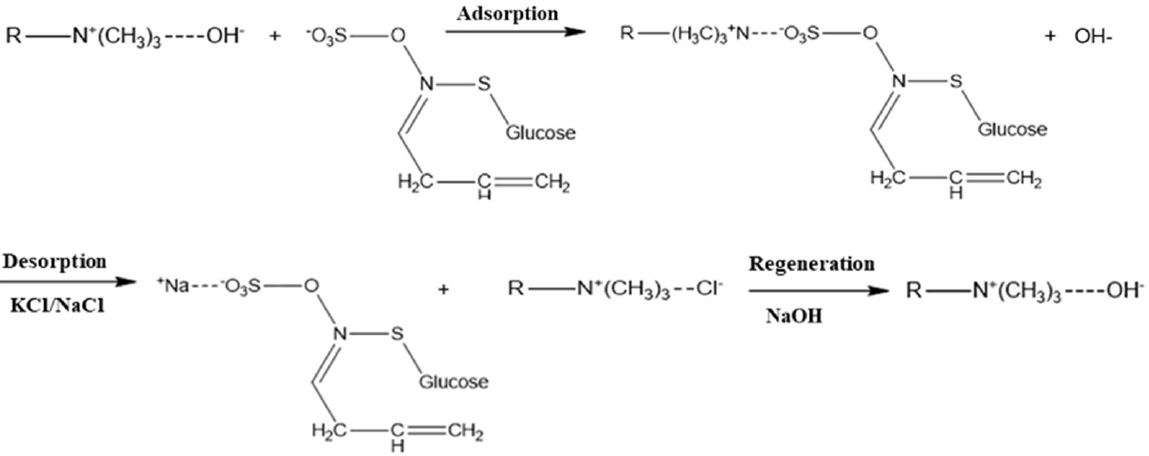
Figure 6. Illustration of sinigrin adsorption and desorption mechanisms using strongly basic anion- exchange resin PA312LOH.